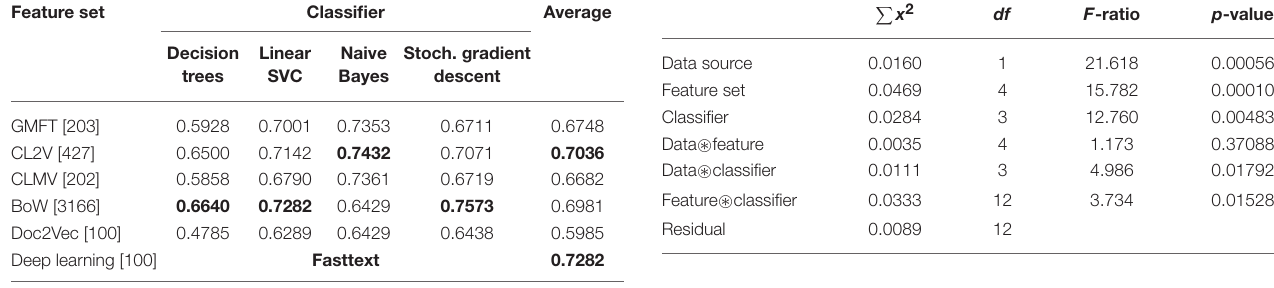
TABLE 4 | Comparison of feature sets and classifiers for sentiment classification of facebook comments. Feature set